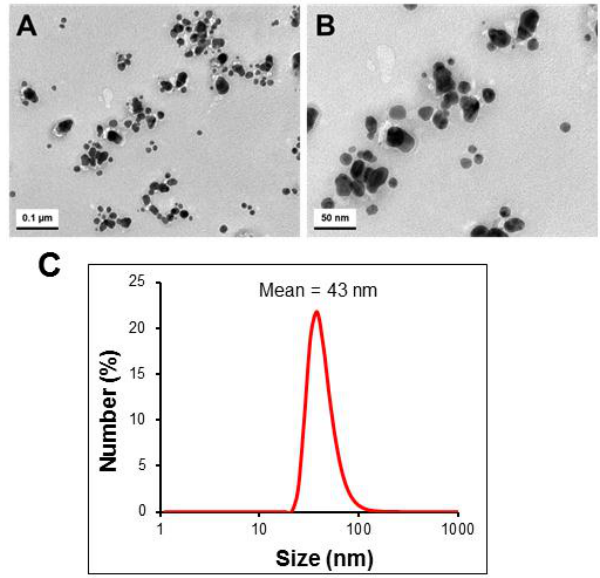
Figure 7. ( A , B ) Transmission electron microscopy images of biosynthesized AgNPs at different magnifications; and ( C ) particle size distribution of AgNPs determined by magnifications; and ( C ) particle size distribution of AgNPs determined by DLS.